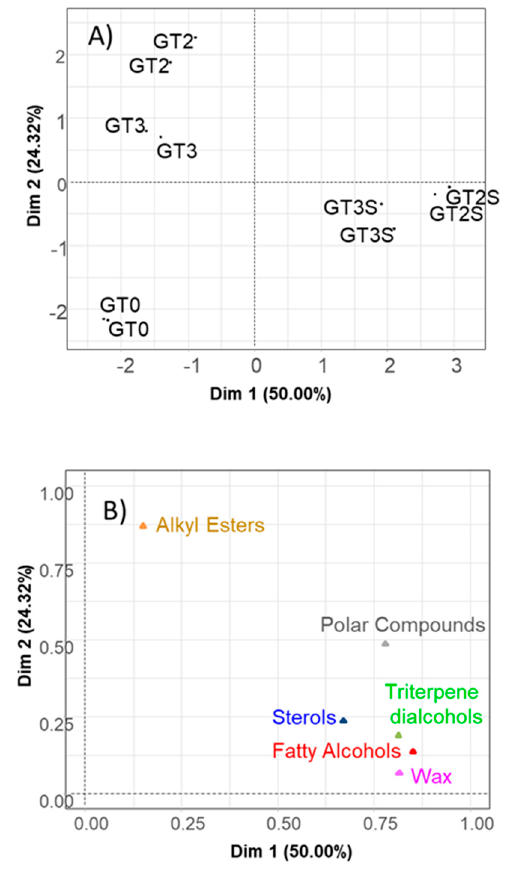
Figure 4. A study, based on the original data, of the minor components’ changes in green Spanish-style Gordal fat according to processing phases and extraction method using Multiple Factor Analysis (MFA): position of the samples ( A ) and groups ( B ) of compounds in the factor map. GT0, GT2 and GT3 are oils extracted from the fresh, fermented and packaged olives, respectively. Samples coded S were extracted by Soxhlet; otherwise, they were extracted by Abencor. Table 2. Coefficient RVs for the correlation between the different groups used for Multiple Factor Analysis (MFA) of minor compounds in the fat from green Spanish-Style Gordal table olives according to processing phases and fat extraction method.